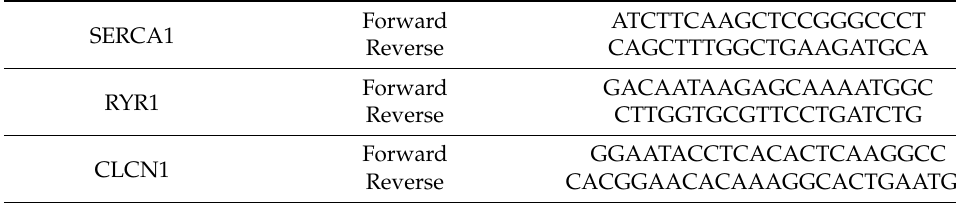
Table 2. Primer sequences for mouse sqPCR.